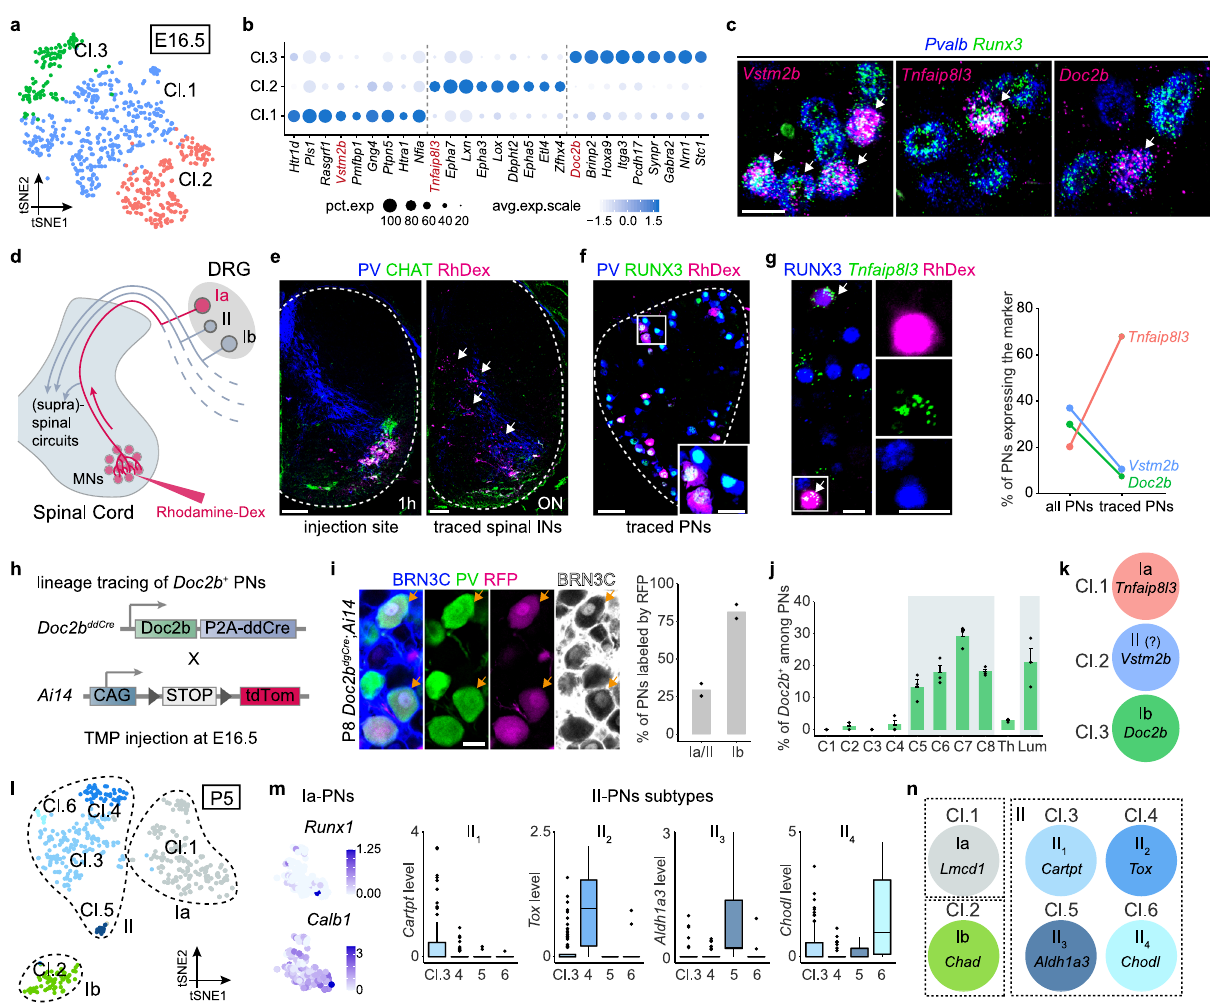
Fig. 5 Emergence of PN subtypes during development. a Three molecularly distinct clusters of E16.5 PNs shown by tSNE. b Dot plot illustrating examples of marker genes in each cluster. c In vivo validation of the three E16.5 PN populations by RNAscope using the identi fi ed markers (magenta) and PN markers Pvalb and Runx3 . Scale bar: 20 µ m. d Strategy to retrogradely label Ia-PNs in E16.5 embryos. e Left: transverse section of spinal cord 1 h post-injection stained for PV and CHAT, showing the injection site in the motor neurons area. Right: transverse section of spinal cord over night (ON) post-injection stained for PV and CHAT, showing the retrogradely labeled pre-motor spinal interneurons. Scale bars: 100 µ m. f DRG section from embryo 6 h post- injection stained for PN markers PV and RUNX3, showing the retrogradely labeled Ia-PNs. Scale bar: 50 µ m. Scale bar of the micrograph: 20 µ m. g Retrogradely labeled DRG section stained for PN marker RUNX3 (immunostaining) and subtype marker Tnfaip8l3 (RNAscope). Right: Proportion of the three PN populations among all PNs ( Pvalb + / Runx3 + ) and retrogradely traced PNs from experiment in d ( n = 4 embryos for Tnfaipl3 and Doc2b , n = 3 embryos for Vstm2b ). Scale bar: 20 µ m. Scale bar of the micrograph: 20 µ m. h Strategy to genetically trace the Doc2b + PNs lineage (TMP: trimethoprim). i P8 DRG section from Doc2b ddCre ;Ai14 mice injected with TMP at E16.5. The sections were stained for PN marker PV and postnatal Ib-PN marker BRN3C. The staining of BRN3C in gray scale is pseudo-coloring from blue. Scale bar: 20 µ m. Right: proportion of Ia/II-PNs and Ib-PNs labeled by RFP, respectively, presenting enriched tracing of Ib-PNs ( n = 2 animals); dots represent values from individual animals. j Spatial distribution of Doc2b + PNs in representative DRG of E16.5 embryos. Data are presented as mean ± SEM ( n = 3 animals). Data for Th. and Lum. regions represent an average of the proportion observed in segments T2-T12 and L1-L5, respectively. k Correspondence between PN types and the clusters identi fi ed by scRNAseq at E16.5. l tSNE of PNs depicting molecularly distinct clusters at P5. m Box and whisker plots showing the marker expression of 4 II-PN subtypes at P5, while Ia-PN subtypes were indistinguishable by their subtype markers at this stage (e.g., Runx1 , Calb1 ). Lower and upper hinges: fi rst and third quartiles; the horizontal line: median; the whiskers extend to the value no further than 1.5 * IQR from the hinge; large dots: outliers. For the box plots, Cl.3 (n = 108), Cl.4 ( n = 96), Cl.5 ( n = 14), Cl.6 ( n = 11). n Correspondence between PN types and the clusters identi fi ed by scRNAseq at P5. Source data are provided as a Source Data fi